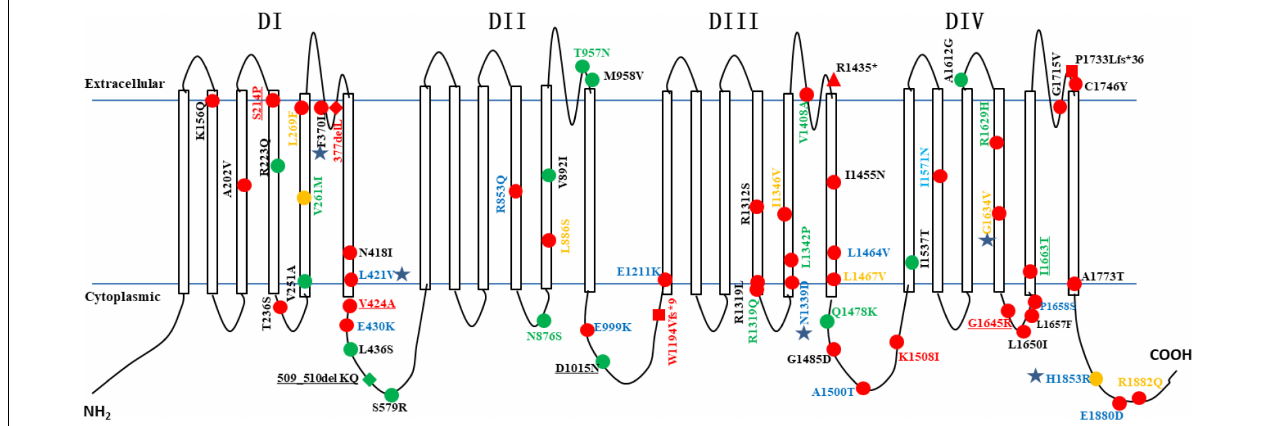
FIGURE 1 | The developmental outcome and treatment effects to oxcarbazepine of epilepsy patients with SCN2A variants. A total of 59 SCN2A variants was included. The shapes of variation sites represent different variation types (circle = missense variation; triangle = nonsense variation; square = frameshift variation; rhombu = in-frame deletion variation). The colors of the shape represent different developmental outcome (red = developmental delay; green = normal development; orange = both patients with normal development and developmental delay were observed). The colors of the variants represent the treatment effects of oxcarbazepine (green = seizure freedom; blue = seizure reduction; orange = no effect; red = seizure worsening; black = never used). The variation underlined indicates fever-sensitivity. Pentagons indicate one patient with the variants